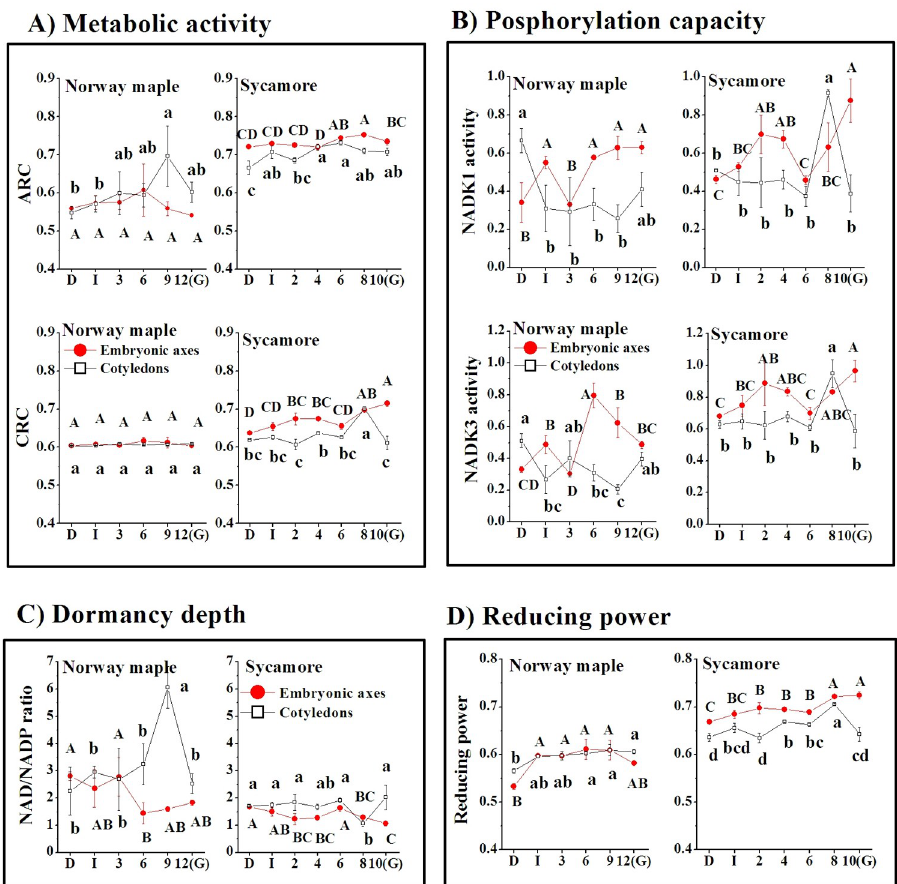
Fig 4. NAD(P)-originated physiological indices. A) Metabolism-related catabolic redox charge (CRC) and anabolic redox charge (ARC); B) phosphorylation capacity of NADK1 and NADK3; C) dormancy depth; D) reducing power. (D) Dry seeds; (I) Imbibed seeds; (G) Germinated seeds. Data represent the mean ± standard deviation of three independent replicates. Statistically significant differences are indicated with different letters (one-way ANOVA followed by Tukey’s test at p � 0.05). The capital letters refer to embryonic axes. peaked in cotyledons at the 8 th WAI just before the accomplishment of germination. Phos- phorylation capacity is the result of NADK1 activity converting NAD + to NADP + or NADK3 activity converting NADH to NADPH (Fig 4B). Phosphorylation capacity peaked at 0.7 in Norway maple embryonic axes at the 6 th WAI. NADK1 activity in sycamore embry- onic axes displayed identical values earlier, between the 2 nd and 4 th WAI, and further increased to 0.9 in the germinated stage. Sycamore cotyledons exhibited a peak of NADK1 at the 8 th WAI, being 2-fold higher than at other germination stages. The phosphorylation capacity of NADK3 displayed similar patterns in seeds of both Acer species; however, its activity was clearly higher in sycamore seeds. The ratio of NAD/NADP pools can be used as an indicator of the depth of dormancy. Norway maple seeds exhibited higher NAD/NADP ratios related to deeper dormancy than sycamore seeds (Fig 4C). A clearly decreasing ratio in embryonic axes is a sign of the gradual alleviation of dormancy in both species. The nico- tinamide redox charge highlights the nicotinamide-based reducing power, which was reported to be higher in sycamore seeds (Fig 4D). Except for the dry stage, embryonic axes and cotyledons of Norway maple exhibited quite similar values, whereas sycamore seeds